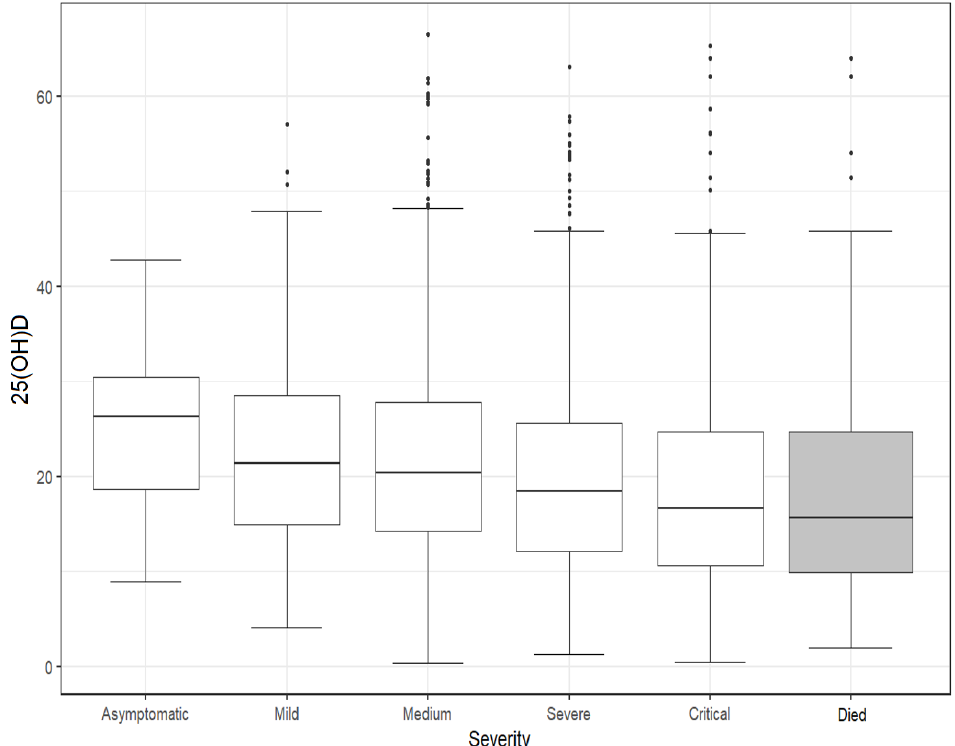
Figure 2. The 25(OH)D serum concentration according to COVID-19 severity and death outcome. The patients who died, with different severity forms, are presented in the grey boxplot. The box shows the median value (horizontal rule), along with the 1st and 3rd quartiles of the observed data (top and bottom of box). Each whisker’s length corresponds to values that are up to 1.5 times the range between the